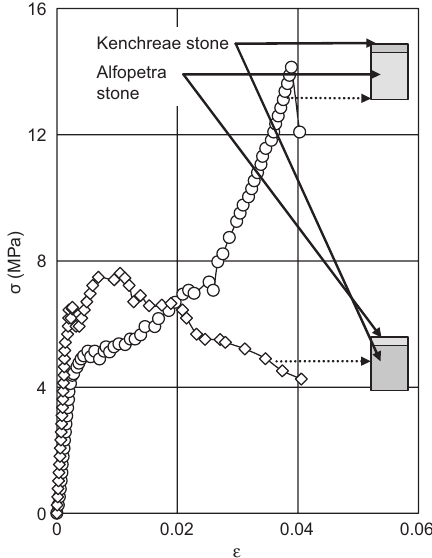
Figure 11 Stress-strain curves for both types of composite speci- mens tested in the present